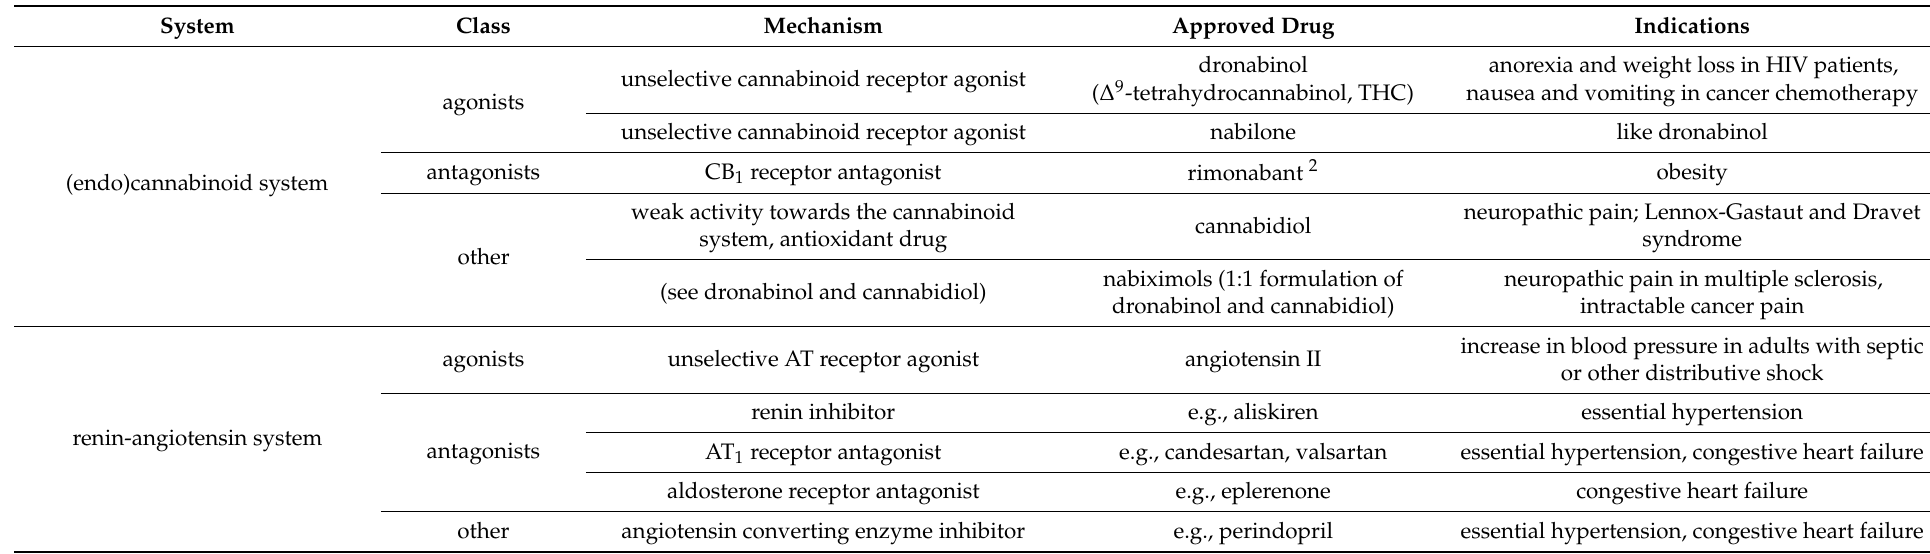
Table 1. Approved drugs targeting the (endo)cannabinoid and renin-angiotensin systems 1 .